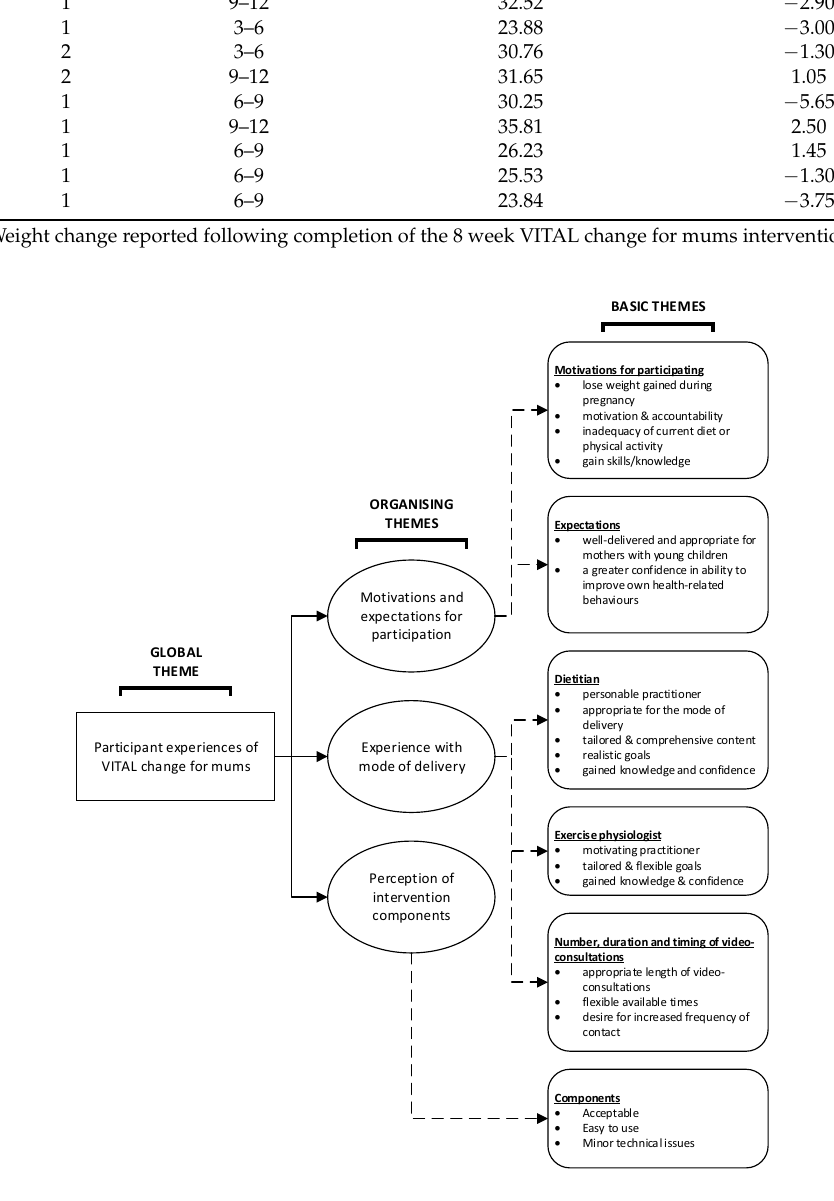
Figure 1. Thematic network of postpartum women’s experiences of participating in Video-coaching to assist lifestyle (VITAL) change for mums.